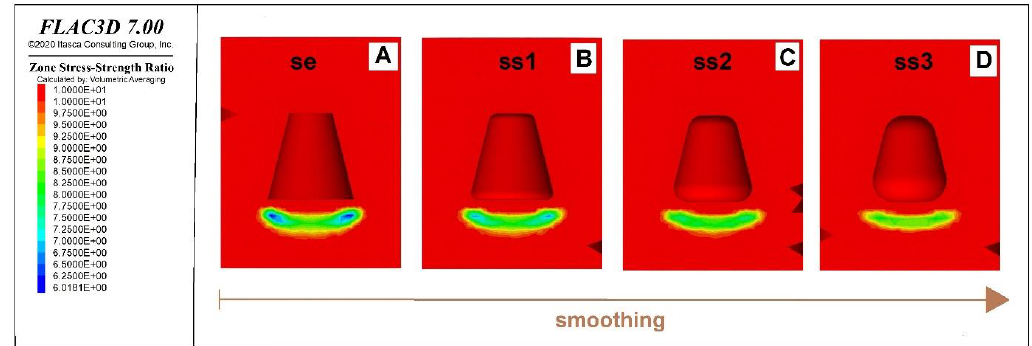
Figure 16. The low SSR value and distribution in the enlarged-bottom caverns with a maximum initial diameter of 120 m; the first injection period ( A – D ).